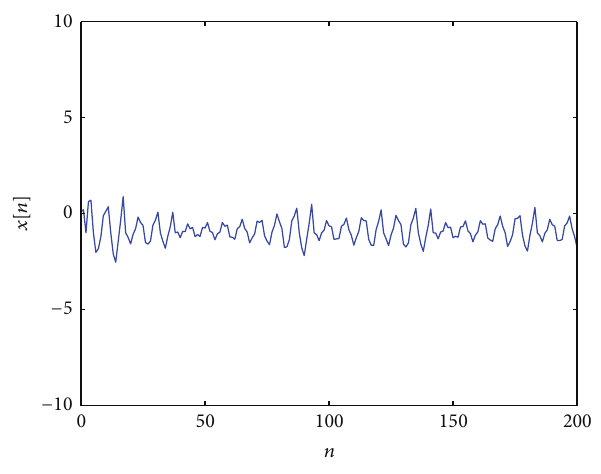
Figure 6: Chaotic orbit satisfies condition (ii).